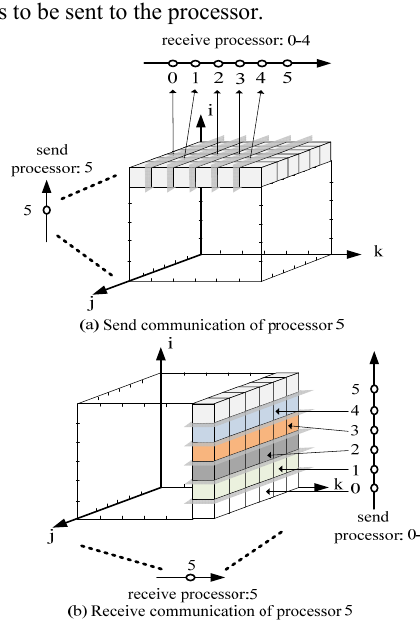
Figure 9. Data-reorganization communication